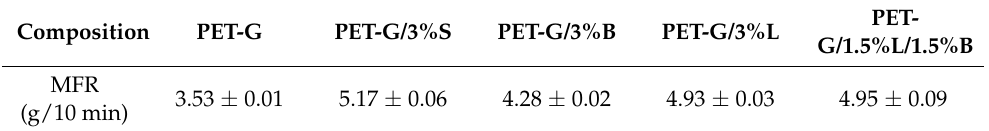
Table 3. Summary of the obtained MFR results.